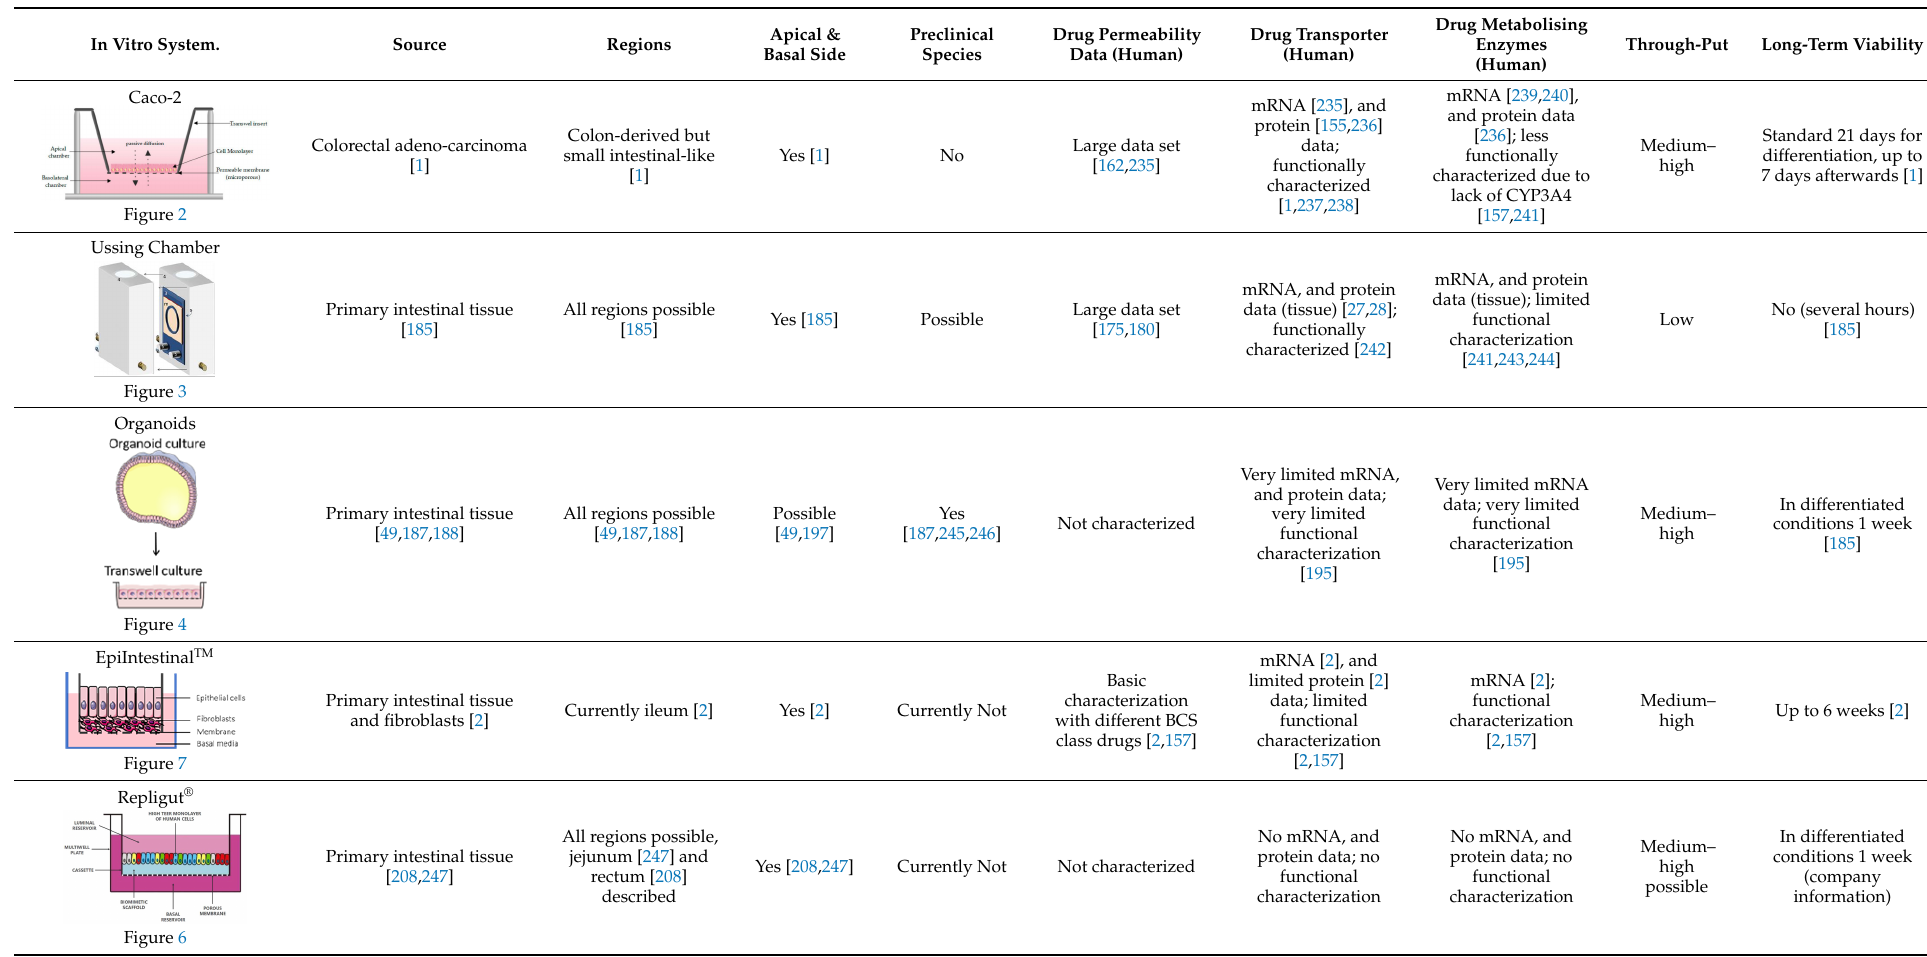
Table 3. Overview of the characteristics of intestinal in vitro tools (epithelial models) discussed in this article. In Vitro System.